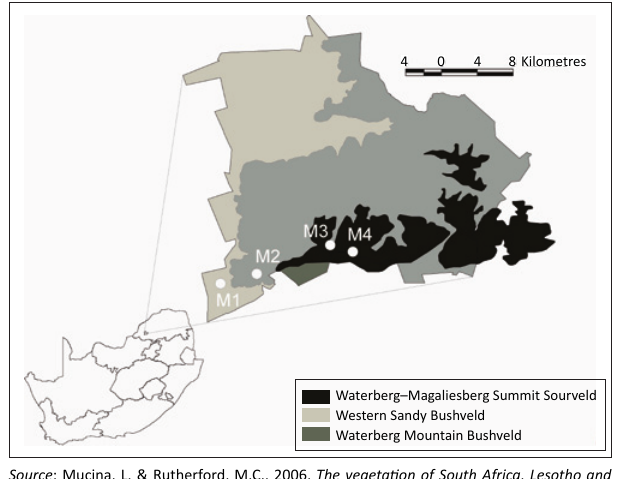
FIGURE 1: Map of the vegetation types in the Marakele National Park. M1–M4 are the sampling locations (pitfall transects of 400 m) for the